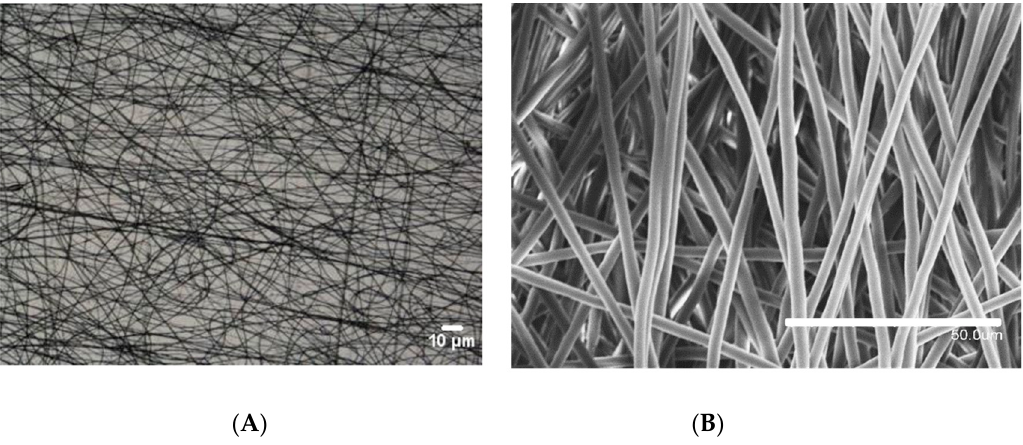
Figure 3. ( A ) Optical microscopy image of the electrospun poly( ε -caprolactone) (PCL) fibers taken at 40×. ( B ) Field emission scanning electron microscope (FESEM) image of the PCL fibers taken at 1000×.